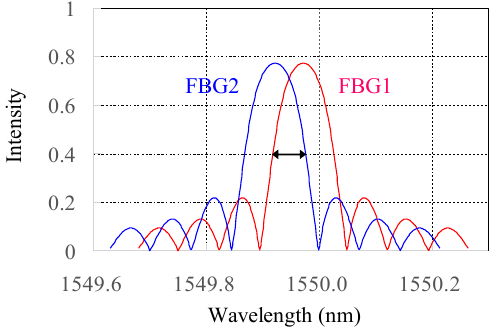
Figure 2. The two reflective FBG spectral correlation by FBG1 moving away from FBG2 during strain.